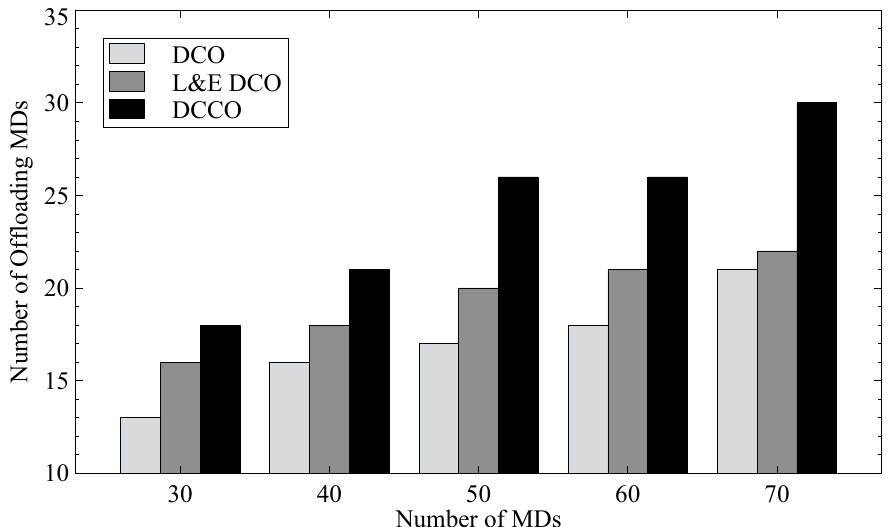
Figure 3. The numbers of offloading MDs for various algorithms.